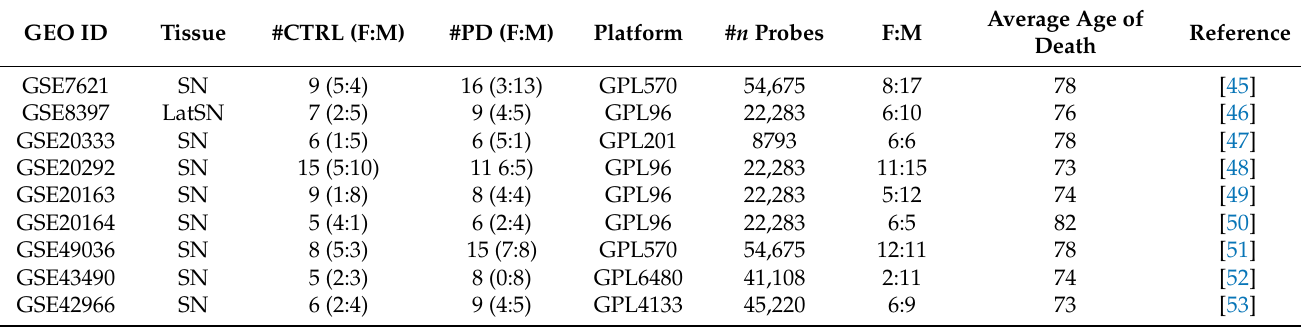
Table 1. Overview of the studies contributing data to our